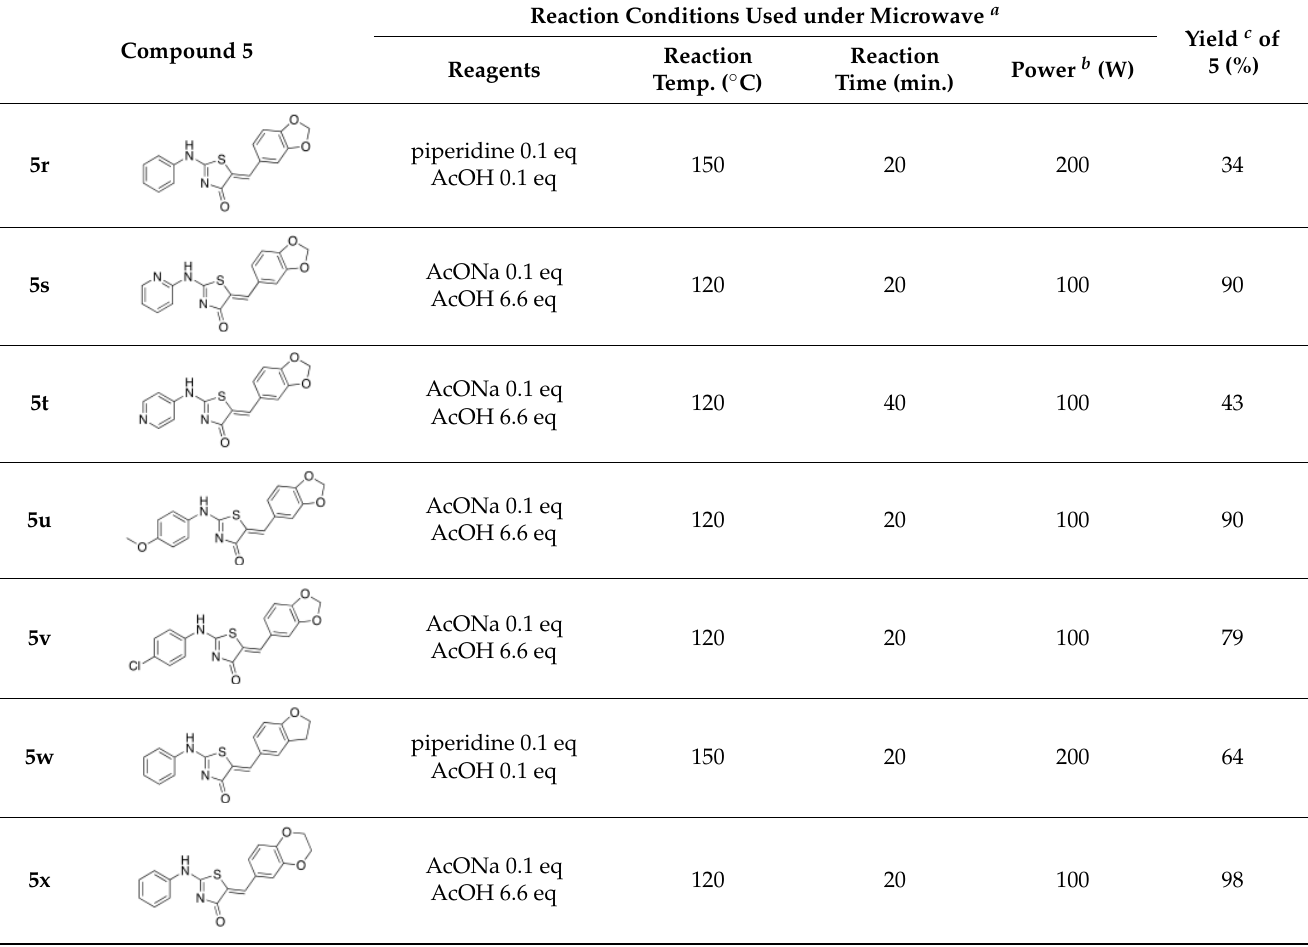
Table 3. Results for the preparation under microwave irradiation of (5 Z ) 2- N -heteroarylamino-5-arylidene-1,3-thiazol-4(5 H )- one derivatives 5r – x from 2- N -heteroarylamino-thiazolidin-4-one 8a – e and aromatic aldehydes 3a – c